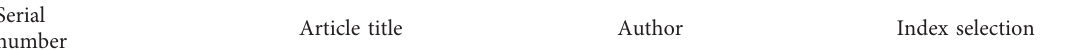
Table 2: Case comparisons of talent growth factor index